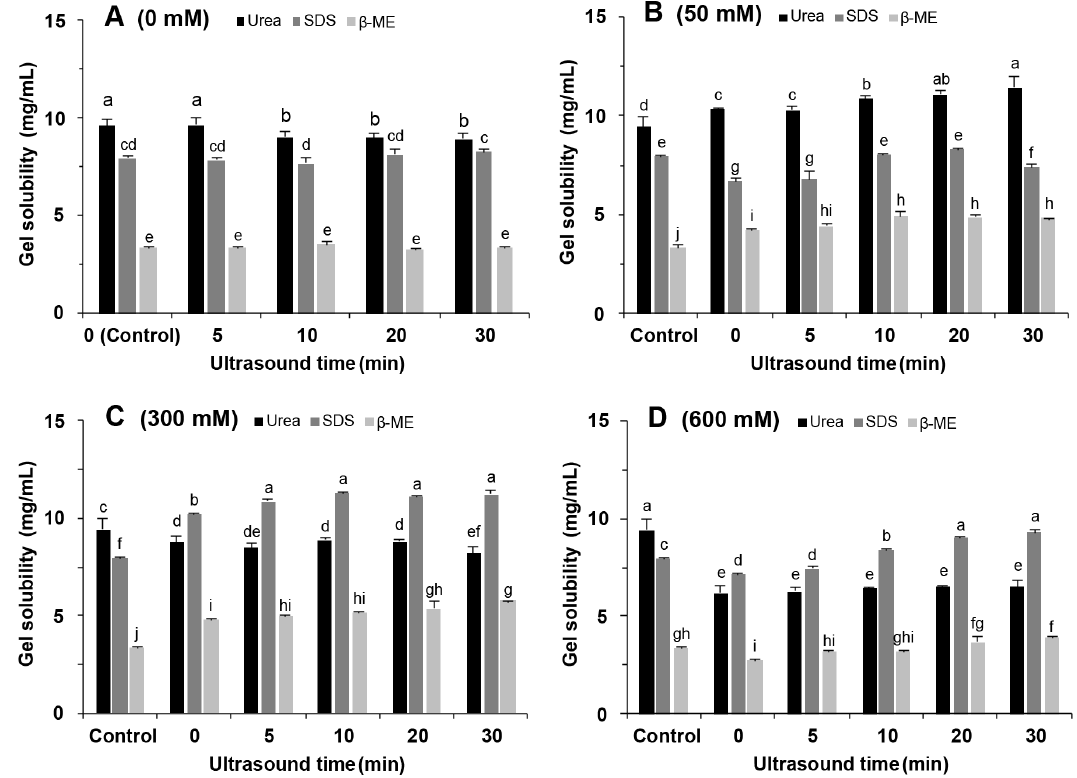
Figure 9. Solubility of soy protein isolate gel in different solvents. ( A ) 0 mM NaCl; ( B ) 50 mM NaCl; ( C ) 300 mM NaCl; ( D ) 600 mM NaCl. Different letters indicate significant differences between groups ( p < 0.05).